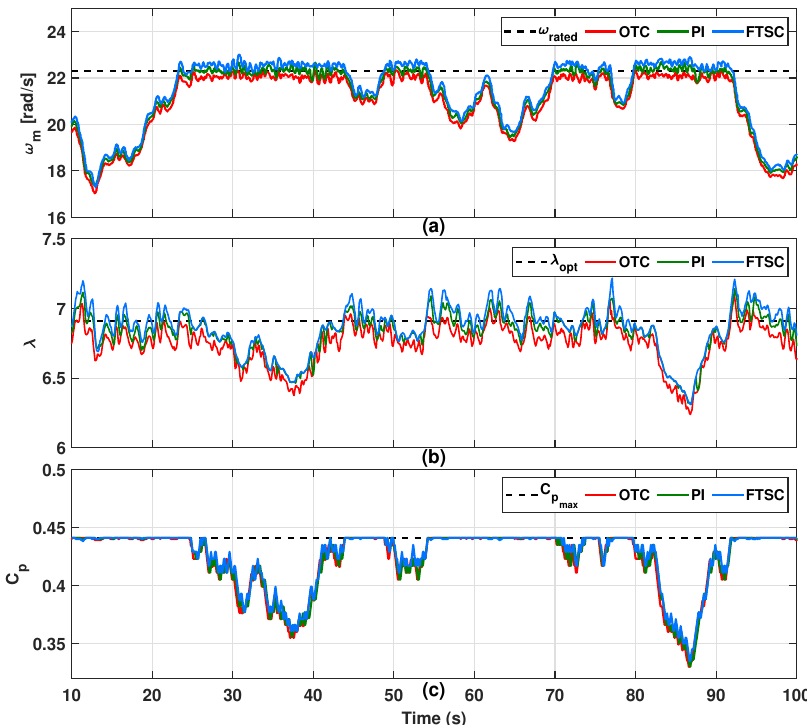
Figure 24. Experimental results for dynamic response comparison of PMVG-based WECS under varying wind profile case-II . ( a ) Rotor speed. ( b ) Tip speed ratio. ( c ) Power coefficient under proposed system in comparison with OTC and PI control